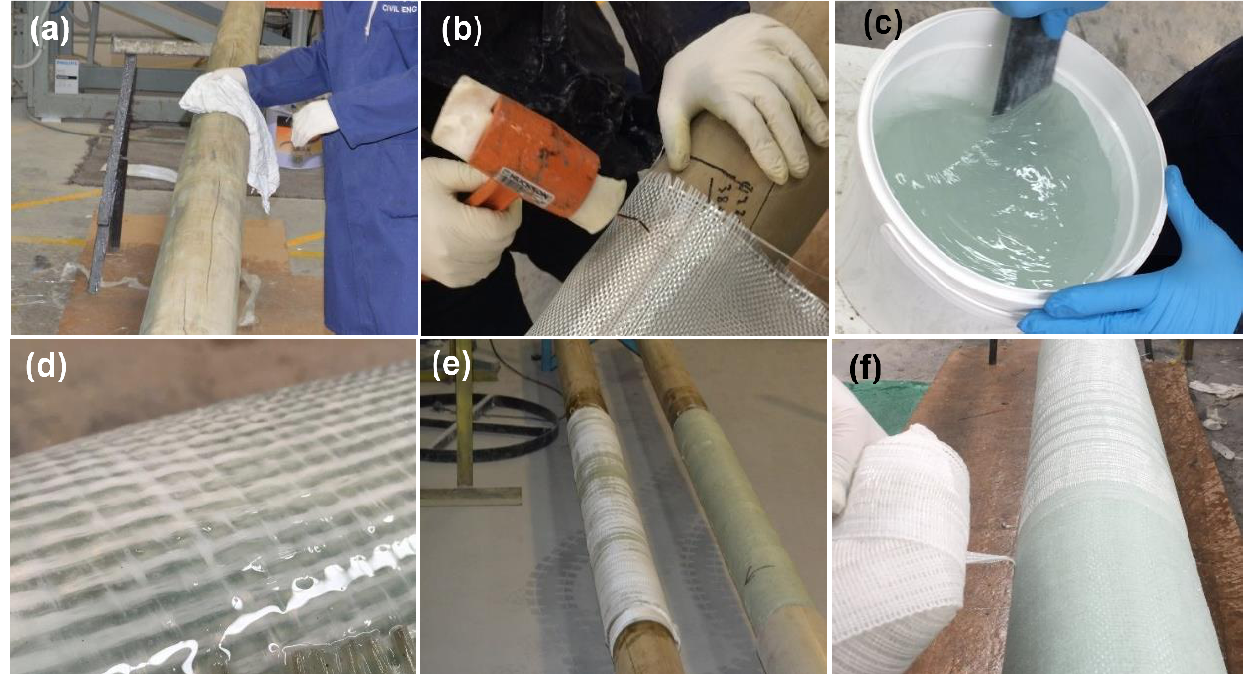
Figure 1. Wet layup process during fabrication of experimental specimens: ( a ) Cleaning the surface; ( b ) attaching the fabric onto the timber pole; ( c ) mixing the epoxy resin with a curing agent; ( d ) applying resin to glass fabric; ( e ) curing after applying peel plies; and ( f ) removing peel plies after one-day curing.